Question: What visual encoding does this figure use to show its data?
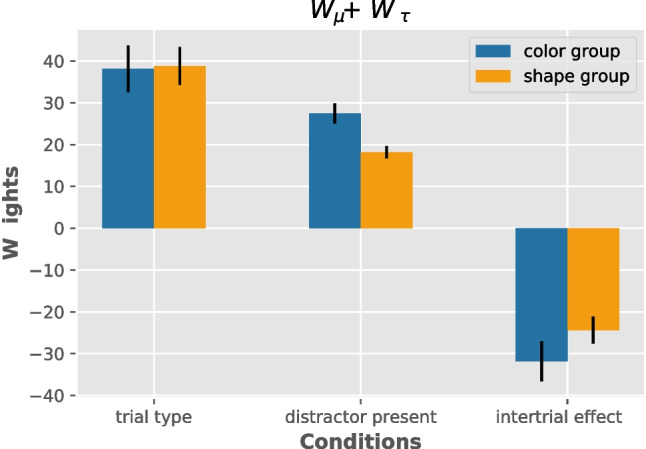
Answer: bar